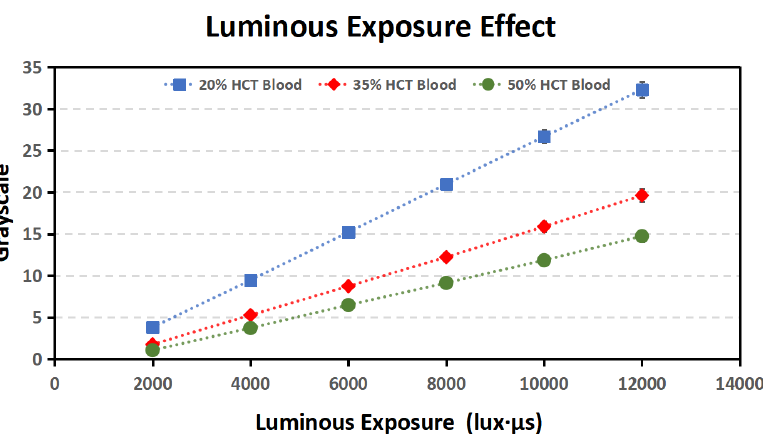
Figure 5. Plot of the luminous exposure vs. grayscale for blood samples with varied hematocrit of 20%, 35%, and 50%.